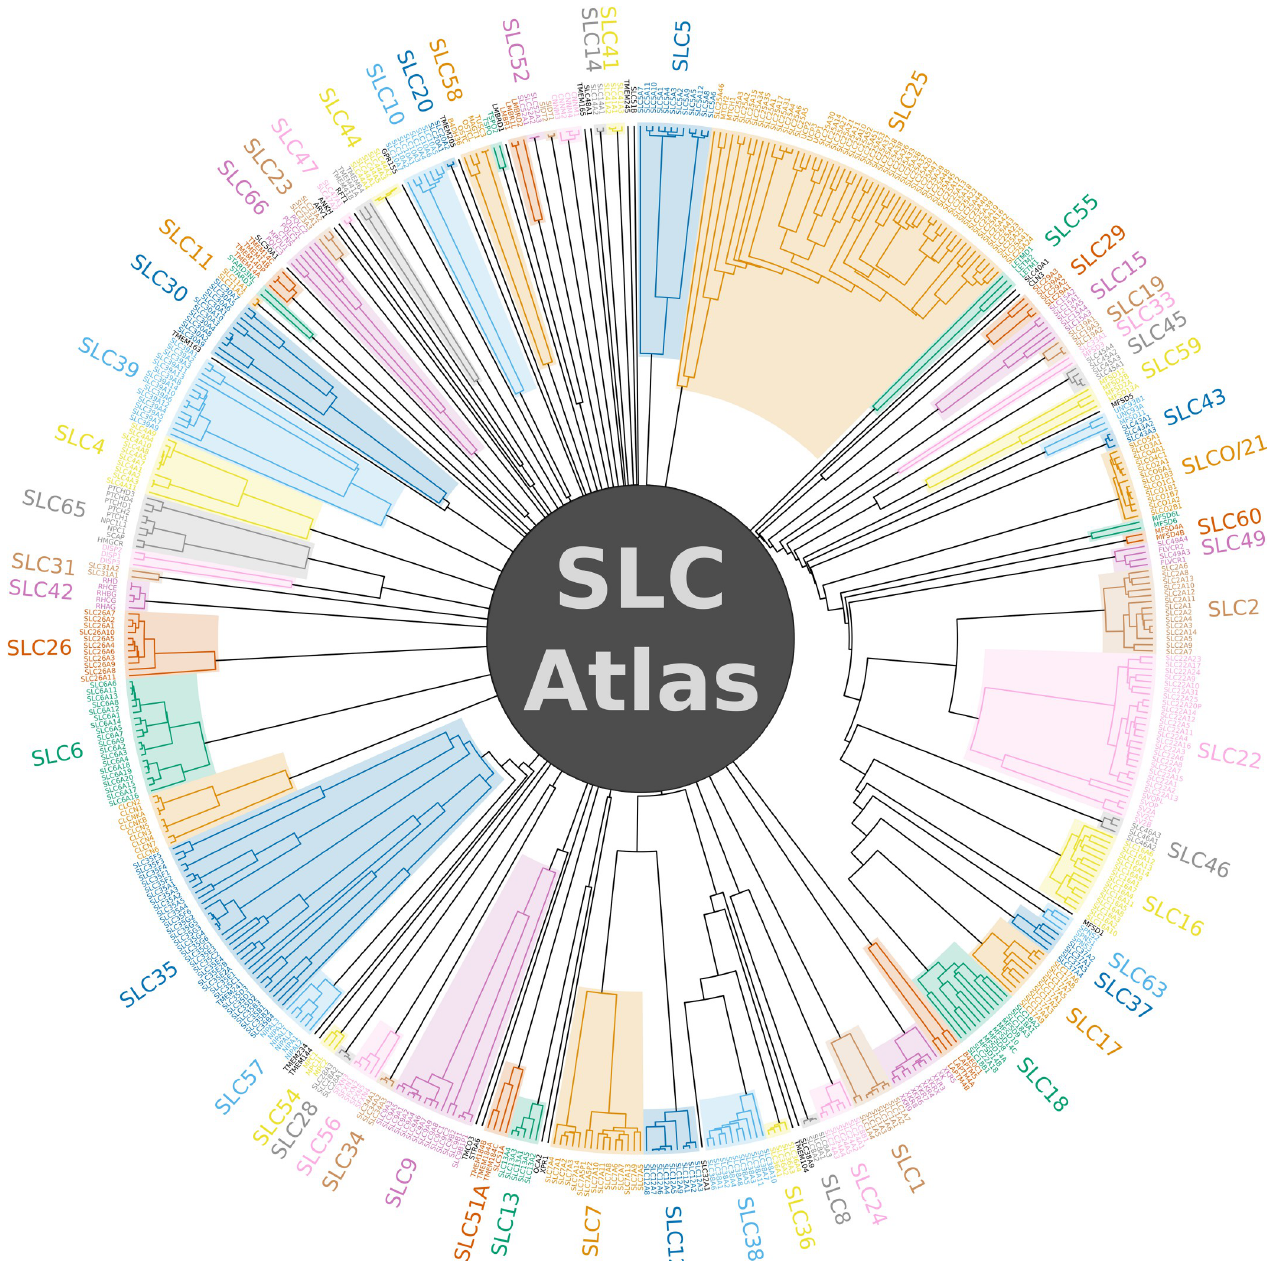
Fig 1. Dendrogram of human SLC-like protein families based on HMM fingerprint-based clustering. Classic and newly incorporated SLC families are shown with colors. Since SLC proteins are polyphyletic, which manifests itself in mathematically orthogonal HMM fingerprints that cannot be further clustered, the dendrogram does not join into a single branch. Branch lengths have been transformed for better visibility (see Methods).